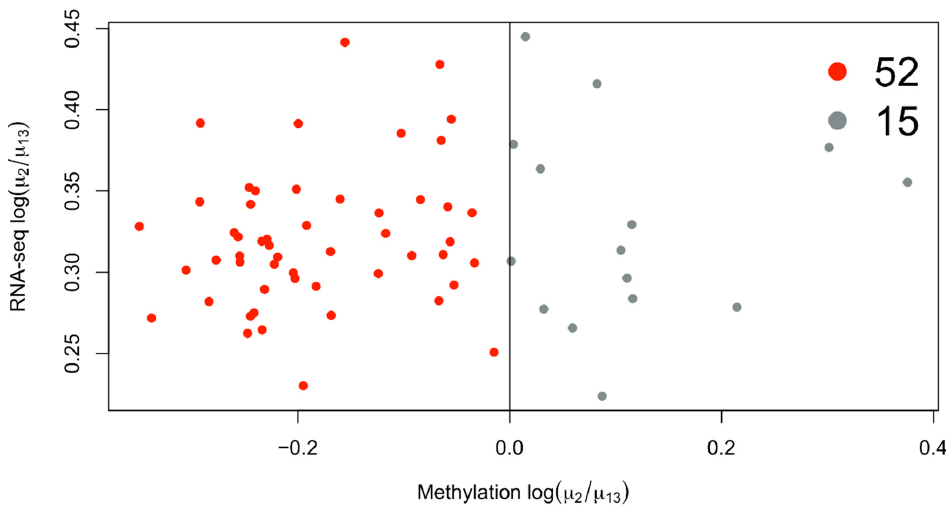
Figure 3. Scatterplot of differentially expressed genes in cluster 2 with available average methylation data. Most of the genes overexpressed in cluster 2 are also downmethylated, considering the average methylation level of the gene.